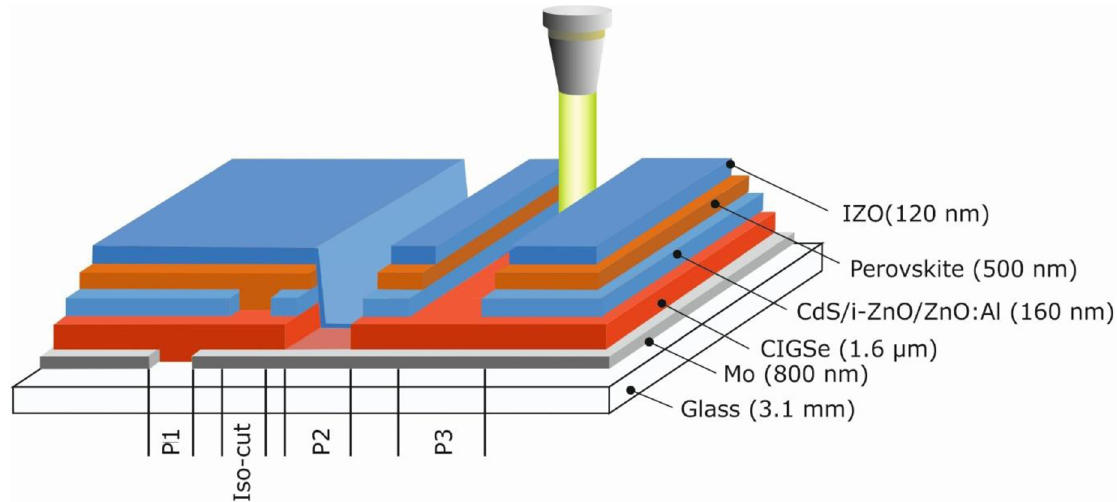
Fig. 1. Schematic cross-sectional representation of the perovskite-CIGSe layer stack with the respective materials and layer thicknesses. The adapted principle of monolithic series interconnection with four patterning steps (P1, iso-cut, P2, P3) adapted to tandem solar cells with a window layer stack is shown. The total width of all four lines including intermediate distances determines the interconnection width (dead area